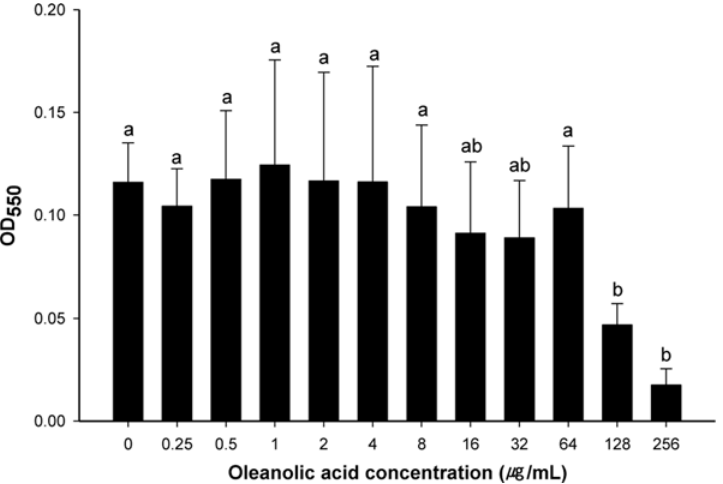
Fig 1. Cytotoxicity of oleanolic acid on HEp-2 cells. Cells were exposed to twofold-dilluted oleanolic acid (0 – 256 μ g mL -1 ) for 48 hours. After exposure, viability of the cell was measured by MTT assay. a-b: means with different letters are significantly different ( P <